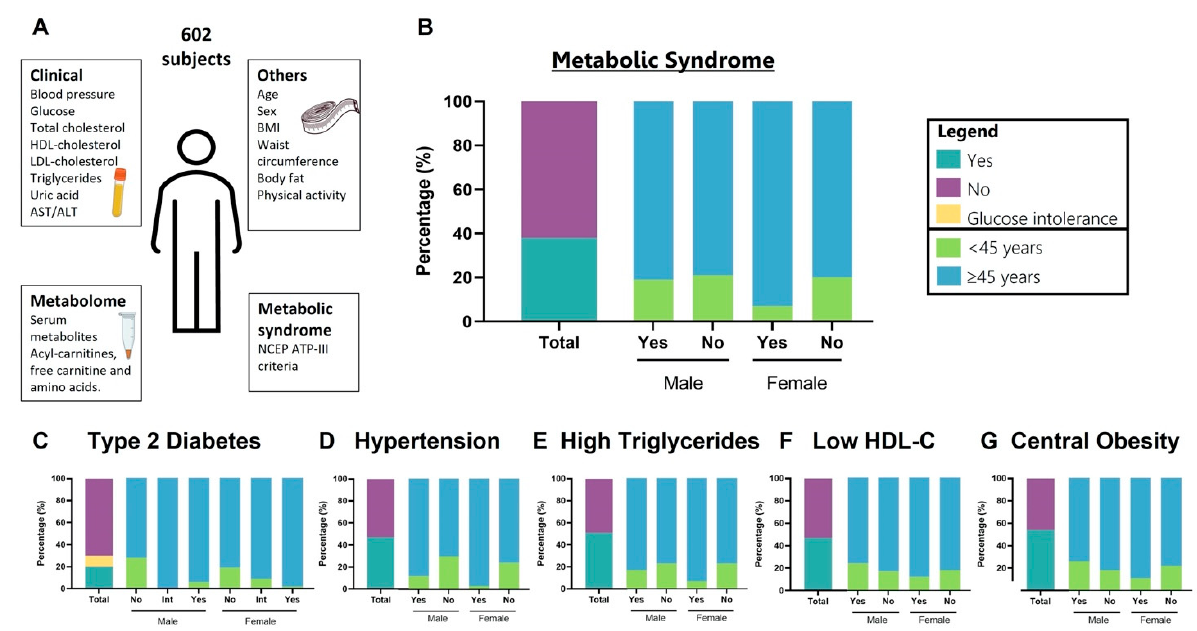
Figure 1. Clinical characteristics of the 602 individuals belonging to the Health Workers Cohort. ( A ) Summary of MetS parameters measured. Each outlined square indicates a different data type and schematically describes the different measurements. ( B ) Percentage of individuals with MetS according to the NCEP-ATP III criteria. Left: global percentage, purple: subjects with the condition, dark green: subjects without the disease. Right: subdivided into males and females. Light green: <45 years subjects, blue: ≥ 45 years subjects. ( C – G ), percentage of individuals with each of the five criteria used for MetS diagnosis is displayed in a similar style to ( B ): yellow designates subjects with glucose intolerance. Table 1. Baseline characteristics of the study population.